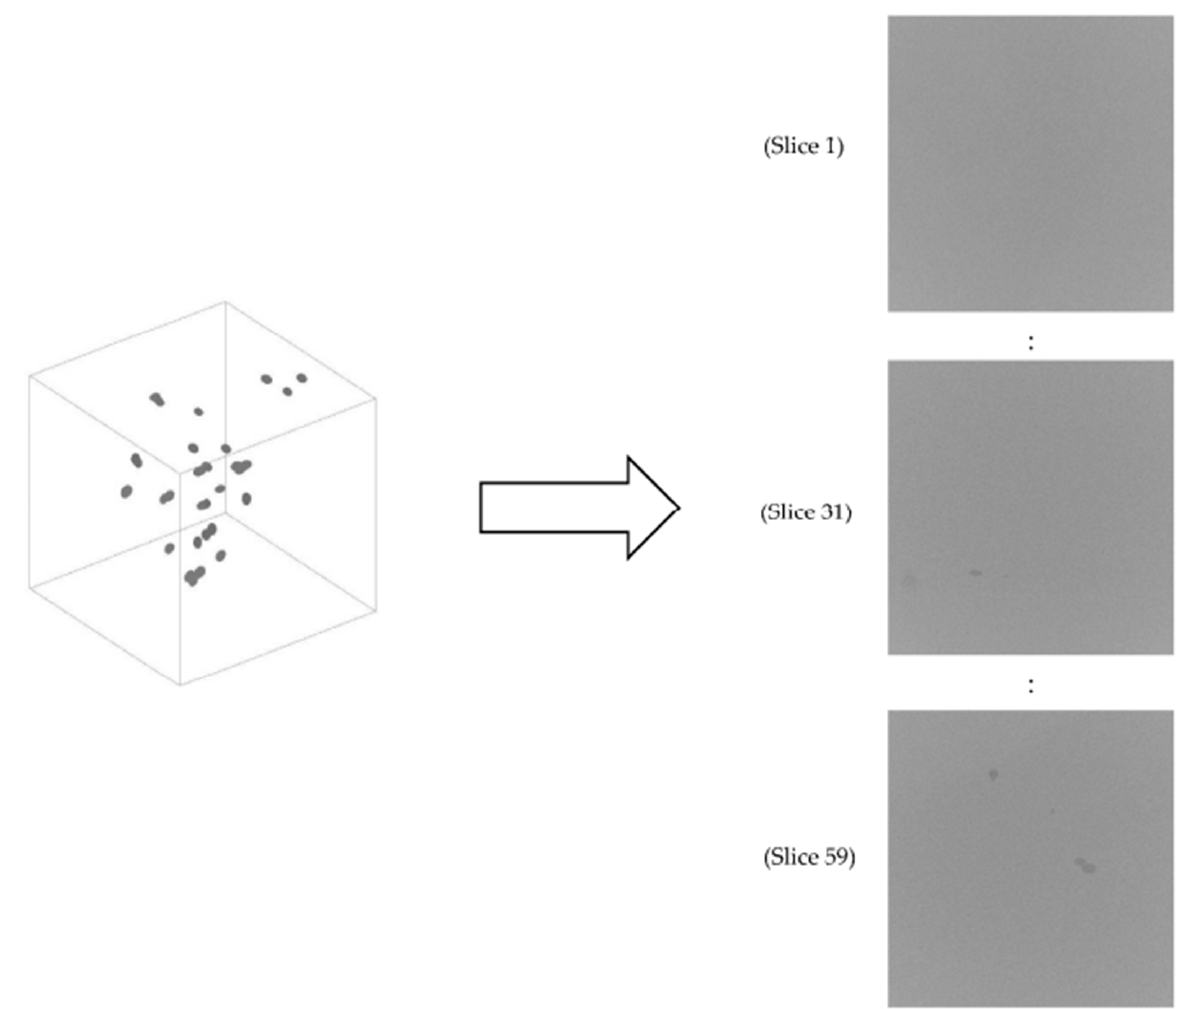
Figure 4. An illustrative example of artificial porosity images [38]. The cube was sliced from bottom to top, so the pattern of the slices is expected to start with no pores, and then, coming to the middle, the pores arise with part of a pore in a slice, and the remaining part of that pore comes in the following slice, as the slice thickness is 0.01 mm in a cube volume of 1 mm 3 . The dependencies between the layers are